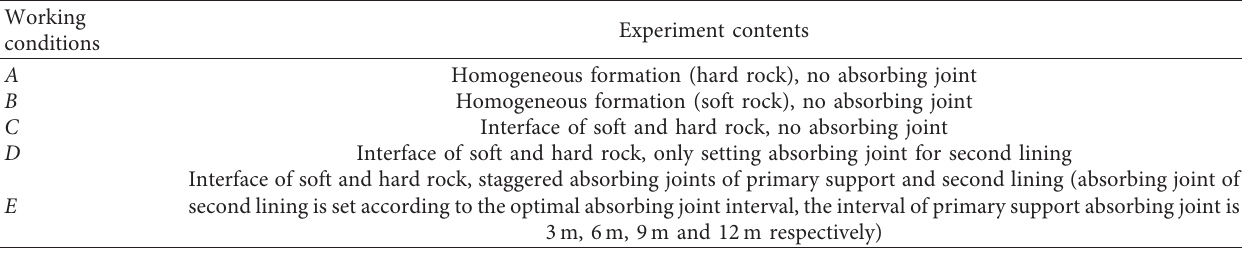
Table 2: Experimental working conditions.